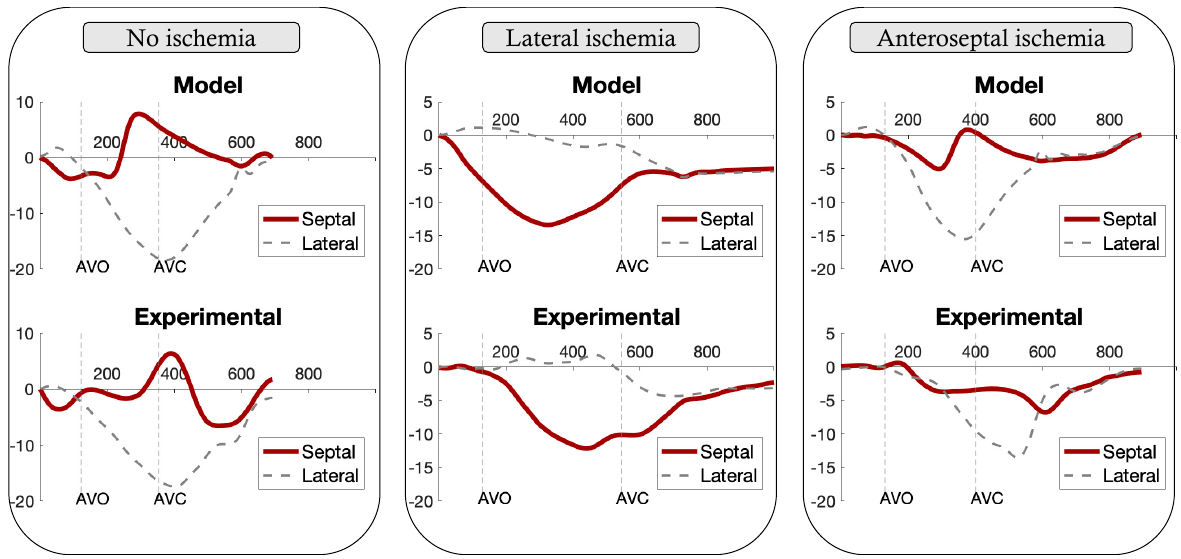
Figure 4. LBBB strain patterns obtained from simulated and clinical data for septal and lateral walls. The septal wall curve was obtained as the average of the five strain curves of septal segments (apical septum, mid inferoseptum, basal inferoseptum, mid anteroseptum, and basal